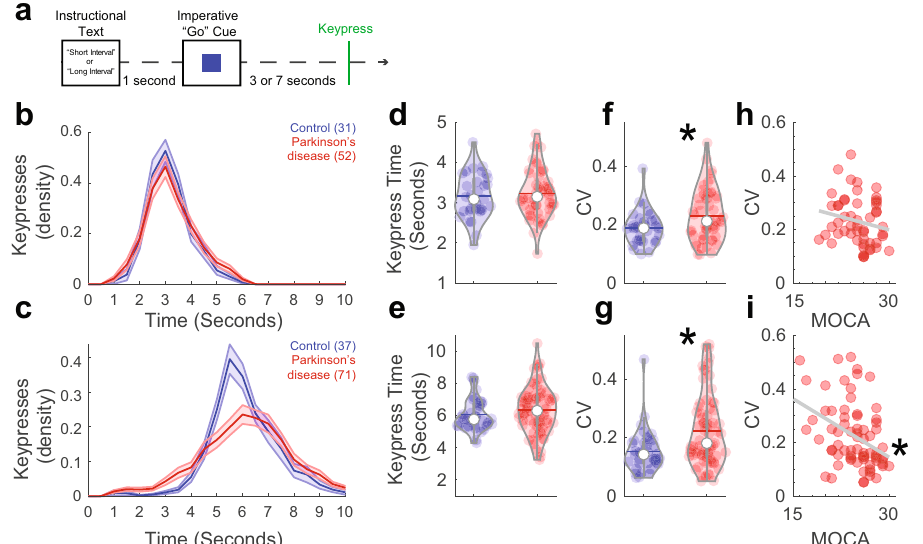
Fig. 1 Timing variability correlated with cognitive dysfunction in Parkinson ’ s disease (PD). a PD patients with a range of cognitive function and demographically matched controls performed an interval-timing task at one of two intervals: 3 s or 7 s. This task required participants to press the spacebar (termed “ keypress ” ) when they estimated the target interval to have elapsed. b Density estimates of keypress over time during 3-s intervals. Of recruited participants, only 31 controls and 52 PD patients had enough trials to analyze for 3-s intervals. c Density estimates of keypress over time for 7-s intervals from controls ( n = 37) and PD ( n = 71) patients. Mean response times for d 3-s and e 7-s intervals for control (blue) and PD patients (red). Timing variability as measured by the coef fi cient of variation (CV) of keypress for f 3-s and g 7-s trials; * P < 0.05 via a t test. Keypress CV correlated with cognitive function as measured by MOCA for h 3-s and i 7-s intervals. * P < 0.05 via Spearman ’ s